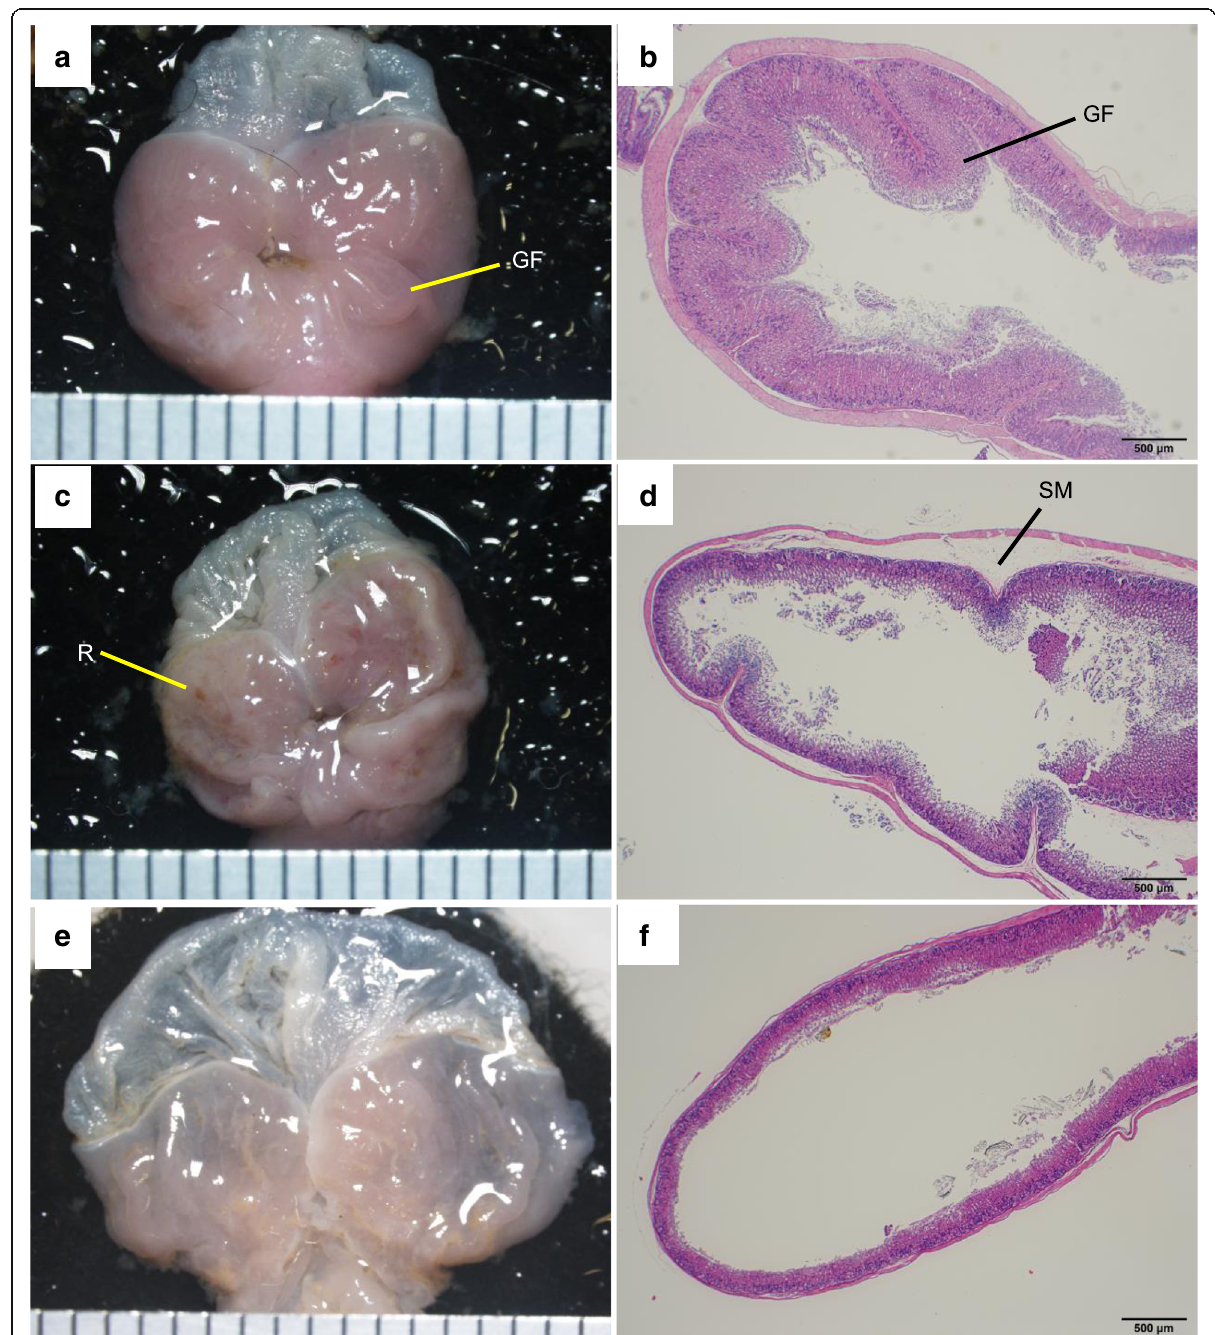
Fig. 6 Pathology of the stomach. A PbA-C57BL/6 mouse with cerebral malaria on day 8 and a PbA-BALB/c mouse on day 15 are shown with uninfected C57BL/6 mouse. a Gastric mucosa of an uninfected C57BL/6 mouse, showing the gastric fold. b Gastric mucosa of the mouse shown in a stained with H&E, showing the gastric fold. c Multiple red patches on the gastric mucosa of a PbA-C57BL/6 mouse. d H&E-stained gastric mucosa of the mouse shown in c , exhibiting gastric submucosal edema. e Dilated gastric mucosa of a PbA-BALB/c mouse. f H&E-stained gastric mucosa of the mouse shown in e , showing thinning of the mucosa and the muscularis propria. GF gastric fold, R red patches, SM submucosal